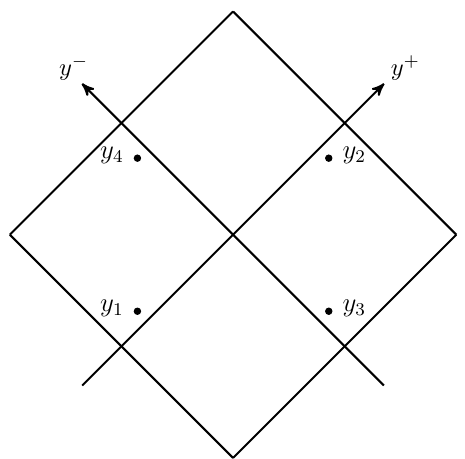
Figure 3 . Kinematics in the central Poincaré patch with coordinates y i . Time is on the vertical axis, transverse directions are